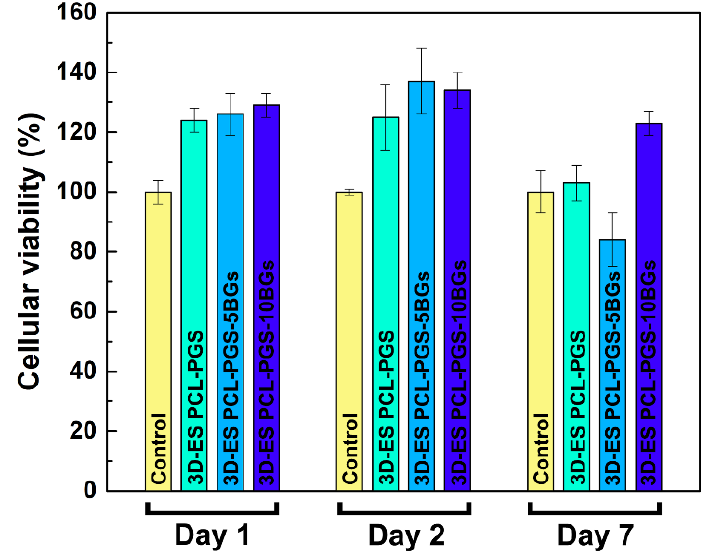
Figure 7. Percentage of 3T3 cell viability for 3D-ES PCL-PGS scaffolds without and with bioactive glasses for three times points (1, 2 and 7 days).